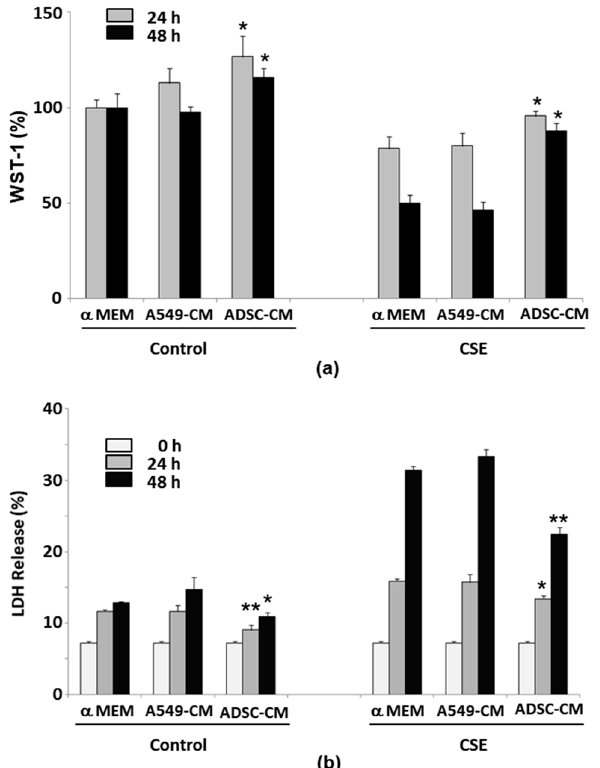
Figure 2. ADSC-CM protects A549 cells from CSE-induced cytotoxicity. ( a ) A549 cells were incubated with standard growth medium ( α -MEM), A549-CM, or ADSC-CM for 24 or 48 h (left panel) or under the same culture conditions plus 50 µ g/mL CSE (right panel). Cell viability was determined at 24 and 48 h by WST-1 assay and was normalized to that of the α -MEM group. In ( b ), as in ( a ), cytotoxicity was determined by LDH release, as in Figure 1. * p < 0.05; ** p < 0.01 compared to α -MEM and A549-CM treatment groups at 24 or 48 h. N = 4. ADSC, adipose-derived stem cell; CM, conditioned medium; CSE, cigarette smoke extract; LDH, lactose dehydrogenase.